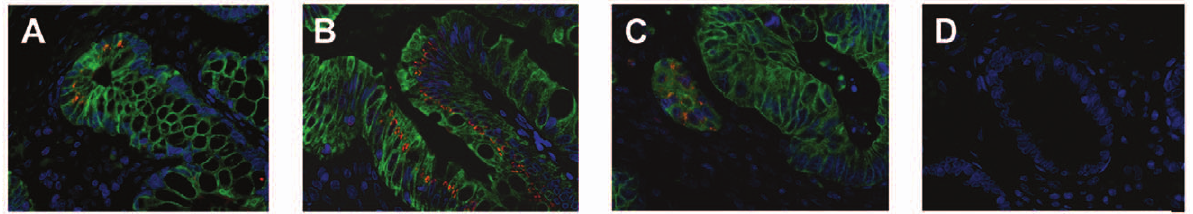
Figure 2. Fc e RI a -chain is expressed in epithelial cells. Co-staining with anti- Fc e RI a -chain (red) and anti-keratin 8 antibodies (green) verifies the epithelial expression of Fc e RI in (A) the crypts of small intestinal section, where Fc e RI a is found primarily in the supranuclear region, in (B) colon tissue and in (C) tumor sample of cancer patient No. 16. (D) Negative control with mouse IgG2b and rabbit IgG. The blue fluorescence DAPI staining indicates the nuclei. Original magnification 6 40.